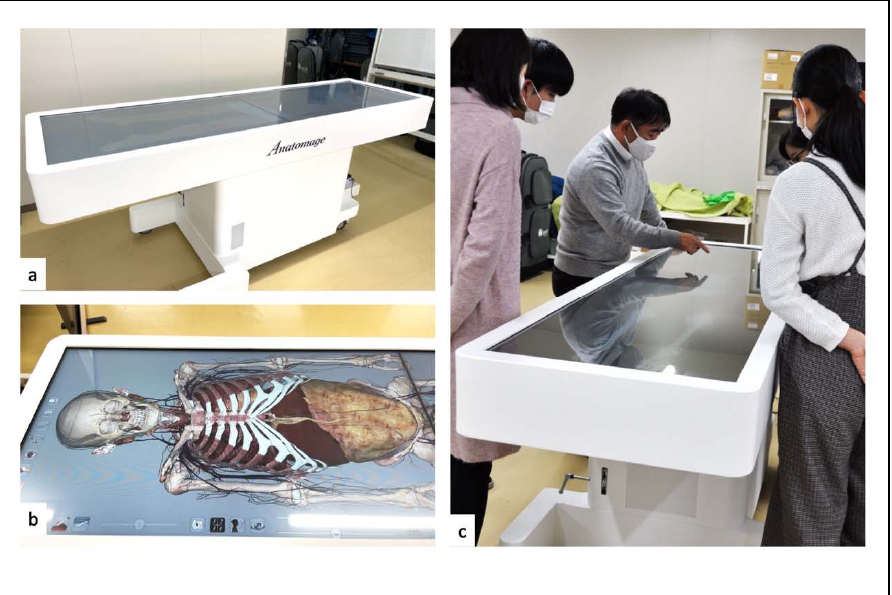
Figure 1. Anatomage Table™: ( a ) Anatomage Table in the horizontal position; ( b ) viewing anatomical images on the screen; ( c ) medical students working in a small group.